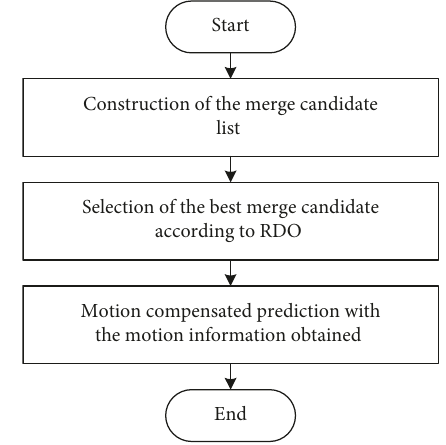
Figure 1: Flow chart of the merge mode.